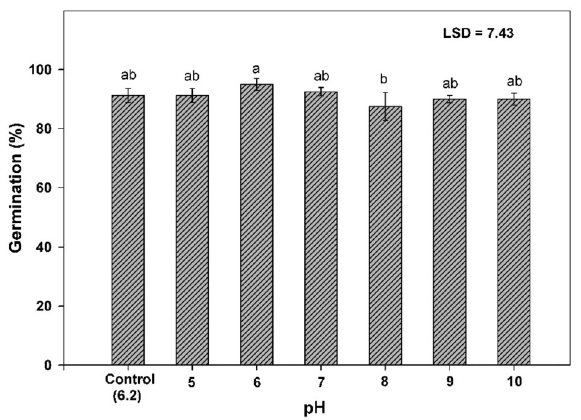
Figure 2. Influence of pH on germination of perennial ryegrass. Nails on the vertical bars represent standard error of the means.